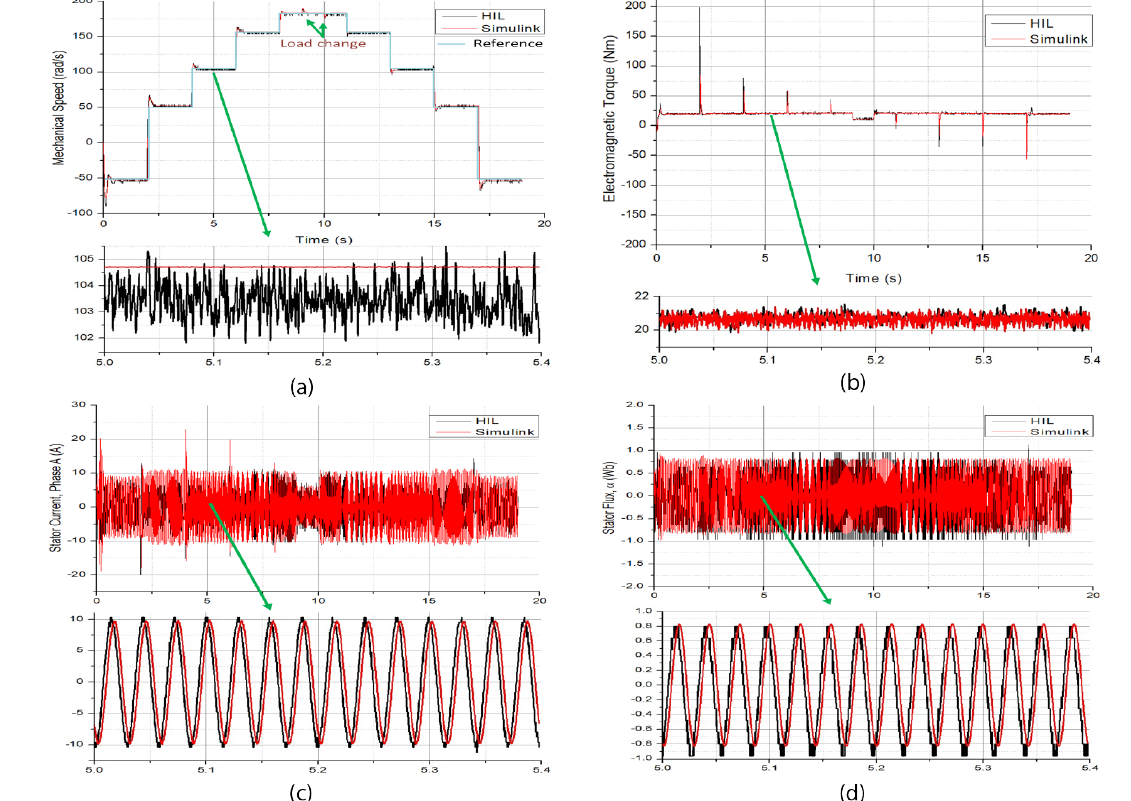
Figure 9. Numerical and practical results of the DIFOC variable speed controller: ( a ) speed; ( b ) torque; ( c ) stator current; and ( d ) stator